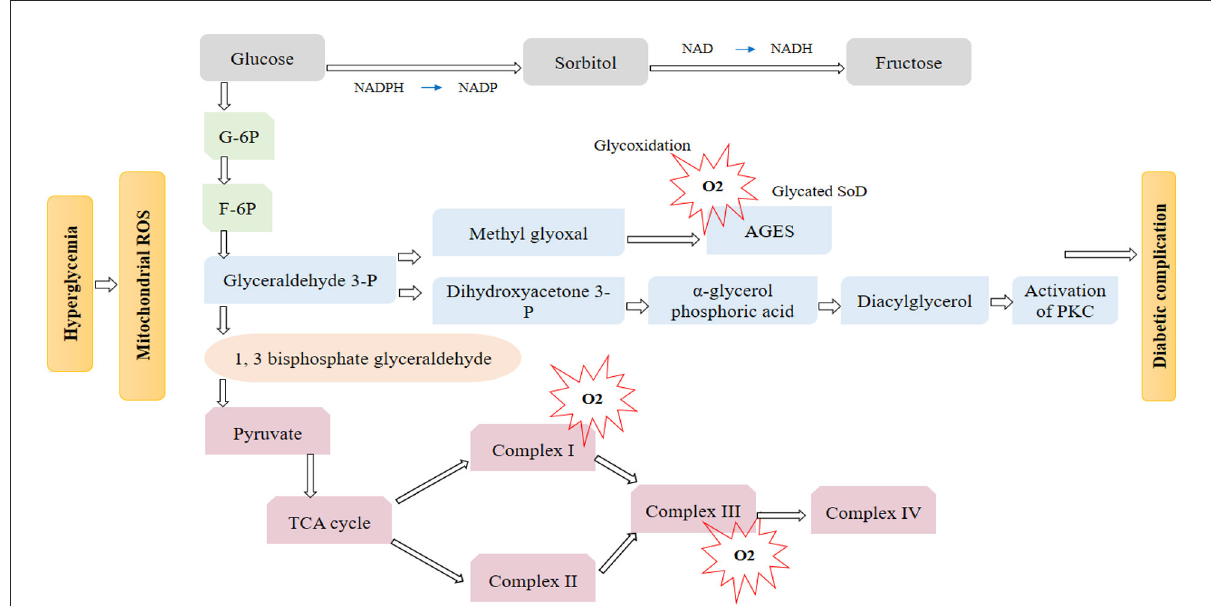
FIGURE1 During high hyperglycemia, reactive oxygen species (ROS) is excessively increased in mitochondria. Three main pathway is responsible for hyperglycemia damage an activation of the polyols pathway, PKC pathway, and accumulation of AGES will prevent diabetic complications